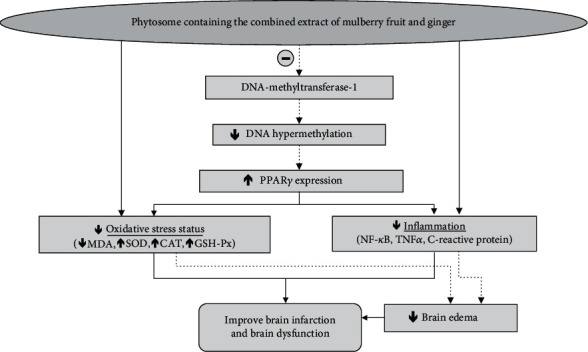
The schematic diagram demonstrated the positive modulation effect of PMG in the animal model of cerebral ischemia in metabolic syndrome condition. PPARγ: peroxisome proliferator-activated receptor gamma; NK-κB: nuclear factor kappa B; TNFα: tumor necrosis factor-alpha; MDA: malondialdehyde; SOD: superoxide dismutase; CAT: catalase; GSH-Px: glutathione peroxidase.